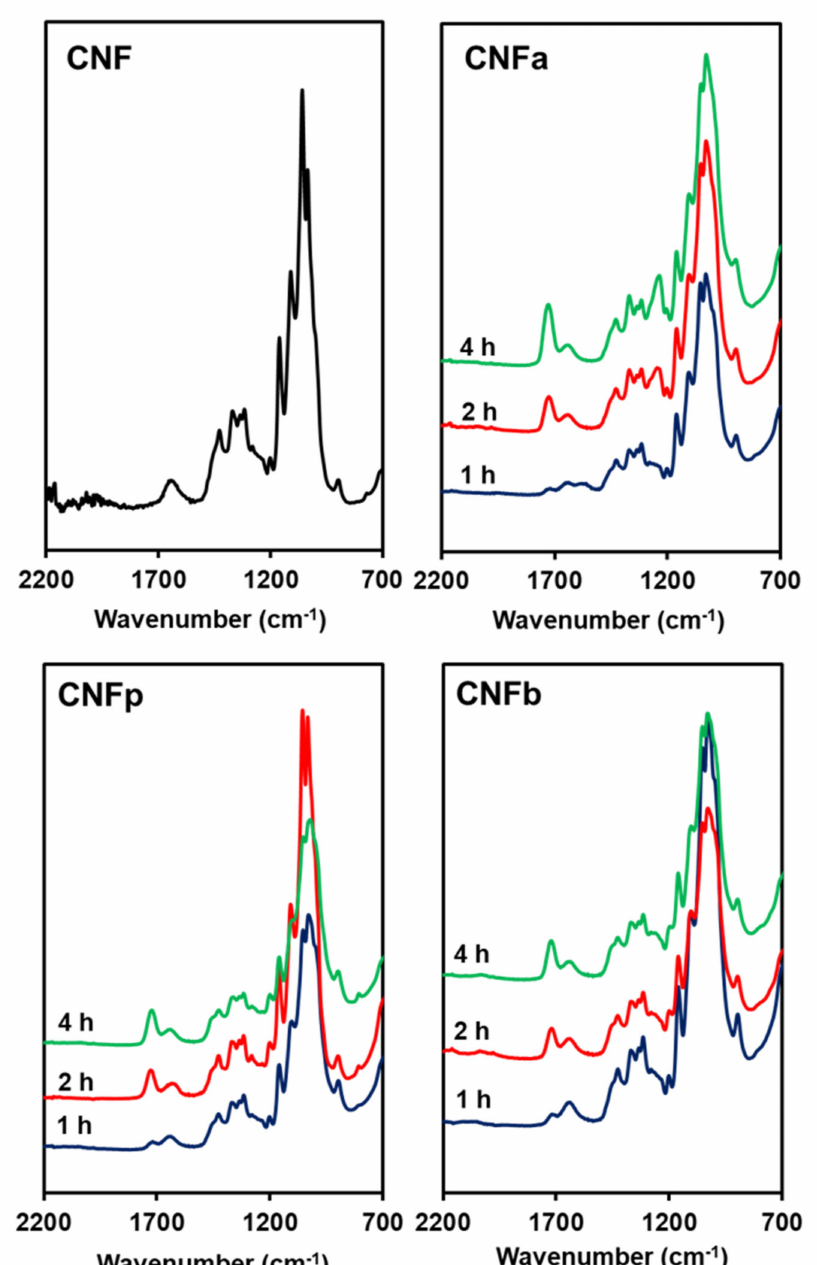
Figure 2. ATR-IR spectra of CNF, CNFa, CNFp, and CNFb.